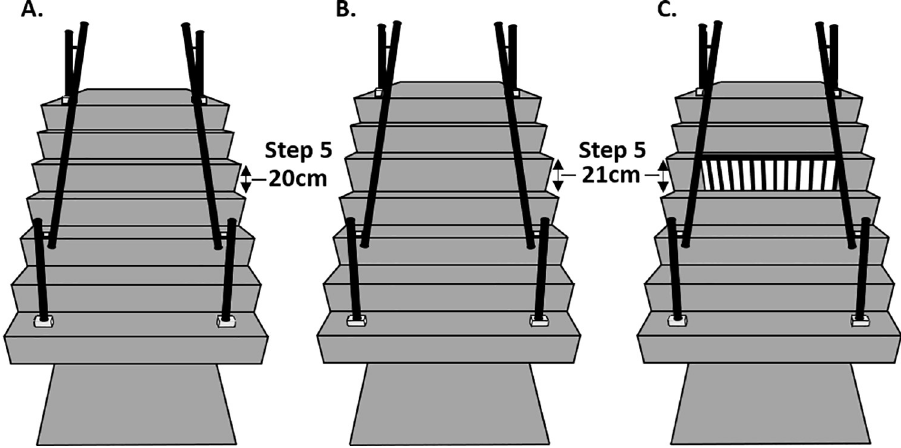
Fig 2. Stair conditions. (A) Consistent. (B) Inconsistent. (C) Illusion. Step 5 riser height for stair conditions B and C was increased by 1cm. The HV illusion design on stair C was characterised by a 70–30% mark space ratio between the white and black stripes on the riser aspect respectively with an abutting edge highlighter on the step going. This design was used as it showed the strongest perception-action link from our previous study [16].